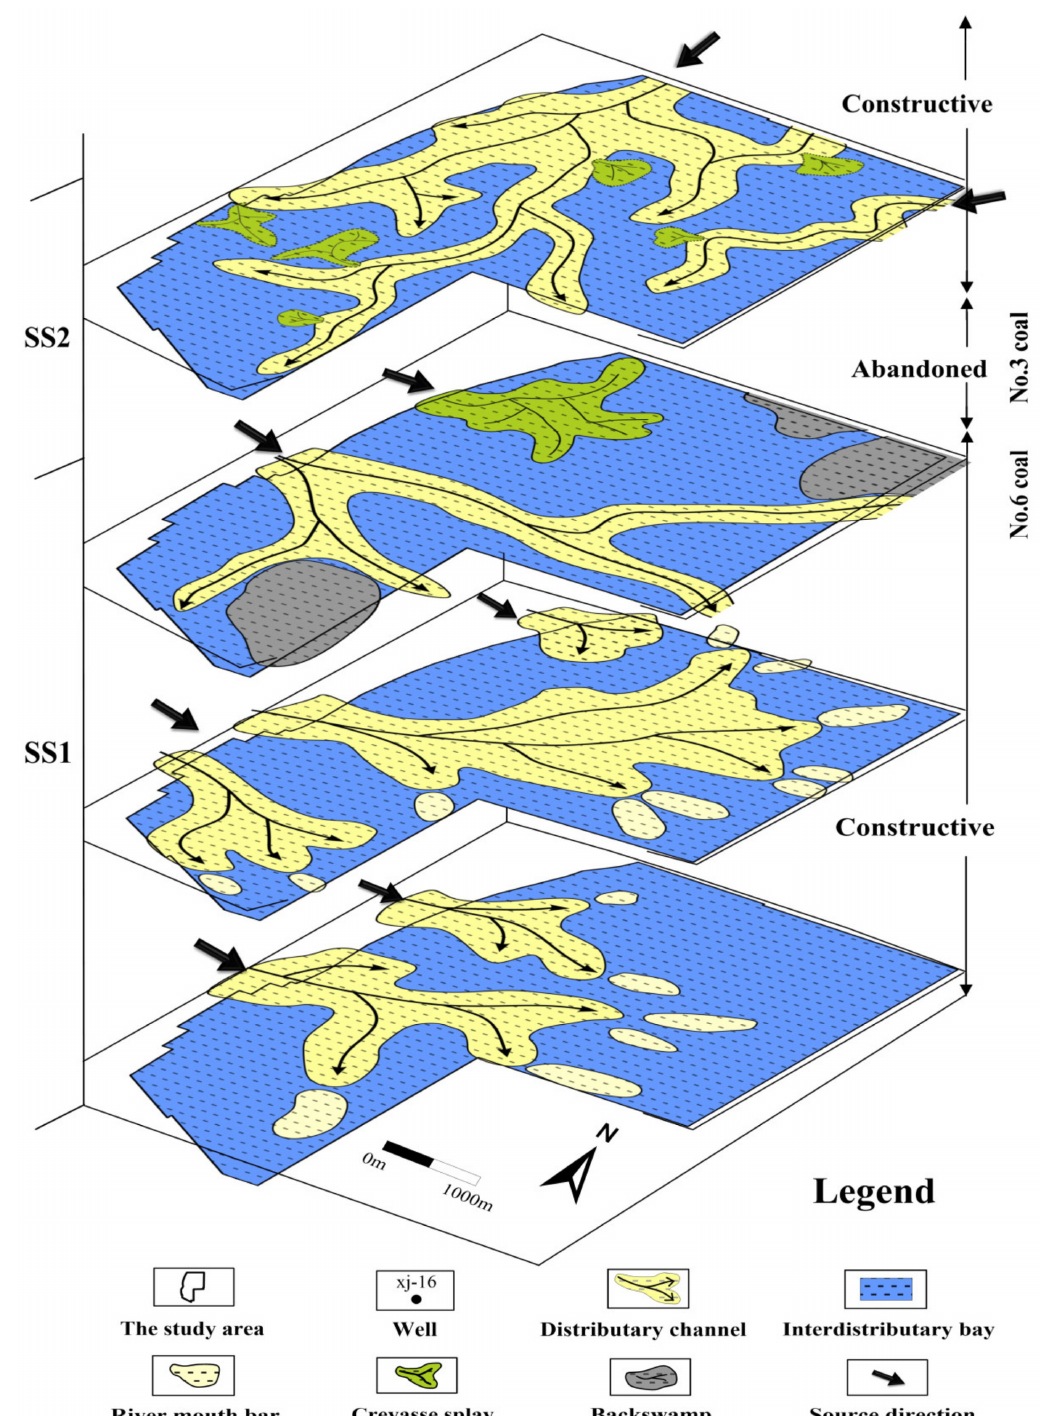
Figure 14. Sedimentary evolution process of the Shanxi Formation. Note that the Shanxi Formation was divided into SS1 and SS2